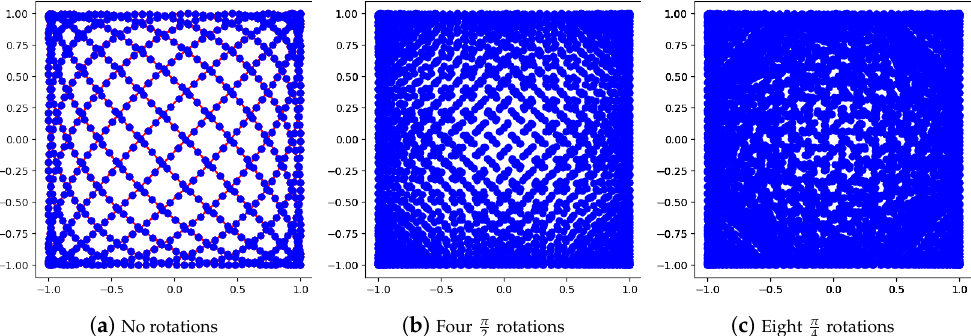
Figure 1. Reducing sampling gaps with rotations. ( a ) The Lissajous curve (red line) and its sampling (blue dots). Note that the Lissajous curve features gaps which cannot be reduced by just increasing the sampling the rate. Instead, the gaps are reduced by merging samplings of rotated versions of the Lissajous curve. ( b , c ) The merged sampling with four and eight rotations,